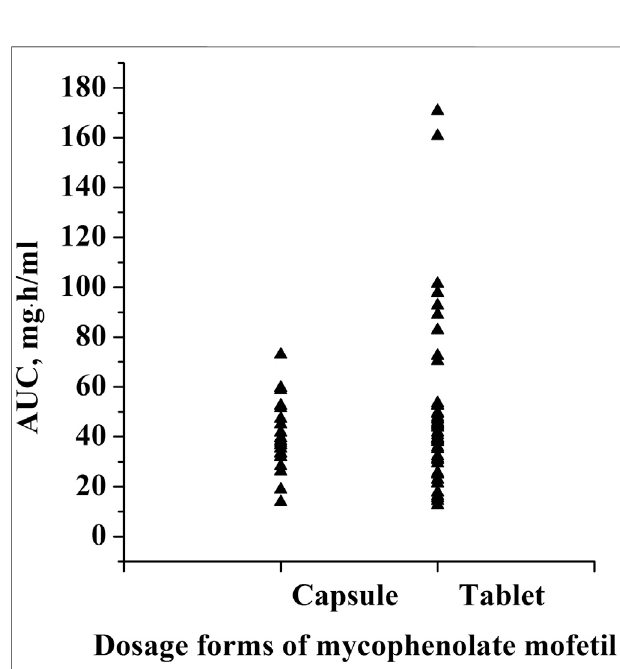
FIGURE 3 | Comparison of AUC results of different dosage